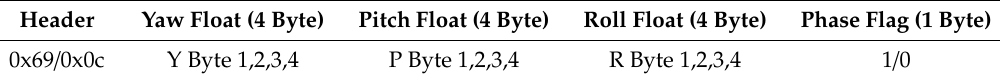
Figure 4. Attitude measurement of the powered geared five-bar (GFB) prosthetic knee. Table 2. Data structures of the transmitted data from the attitude measurement platform.